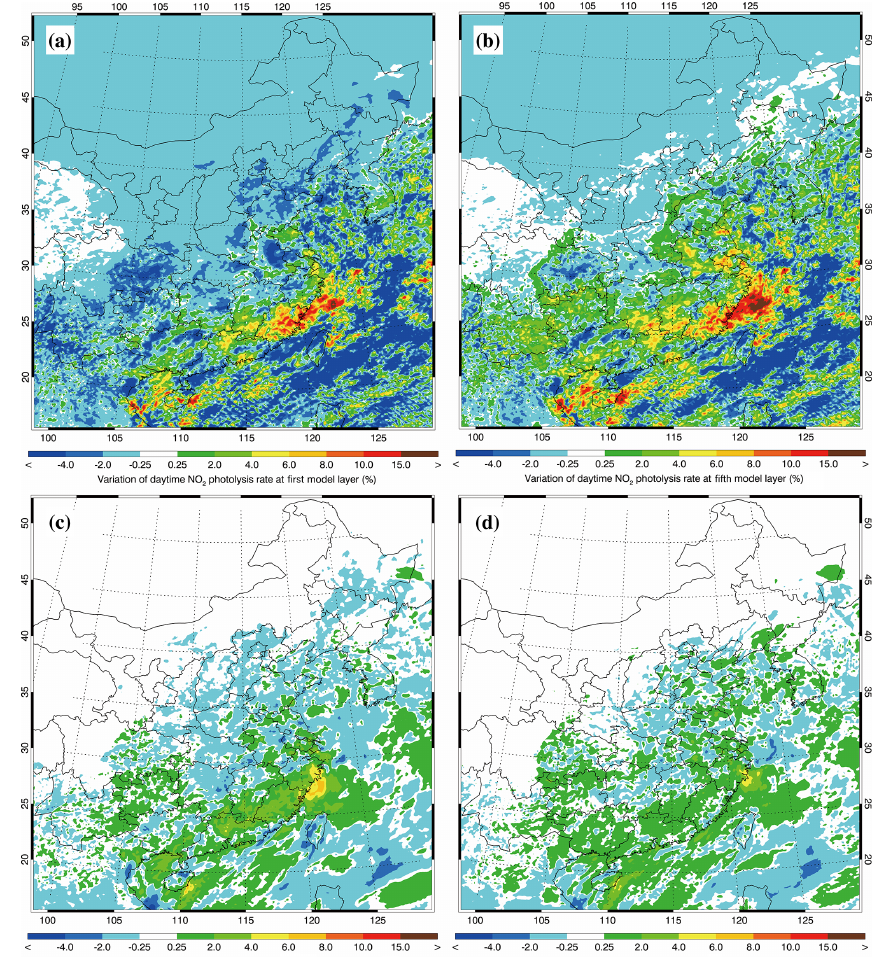
Figure 9. Average variations in daytime (a), (b) NO 2 photolysis at the first and fifth model layer, respectively, and (c),(d) O 3 concentration at first and fifth model layer at around 18 and 420m above the ground surface, respectively, caused by the ALW from 5 December 2015 to 4 January 2016 in